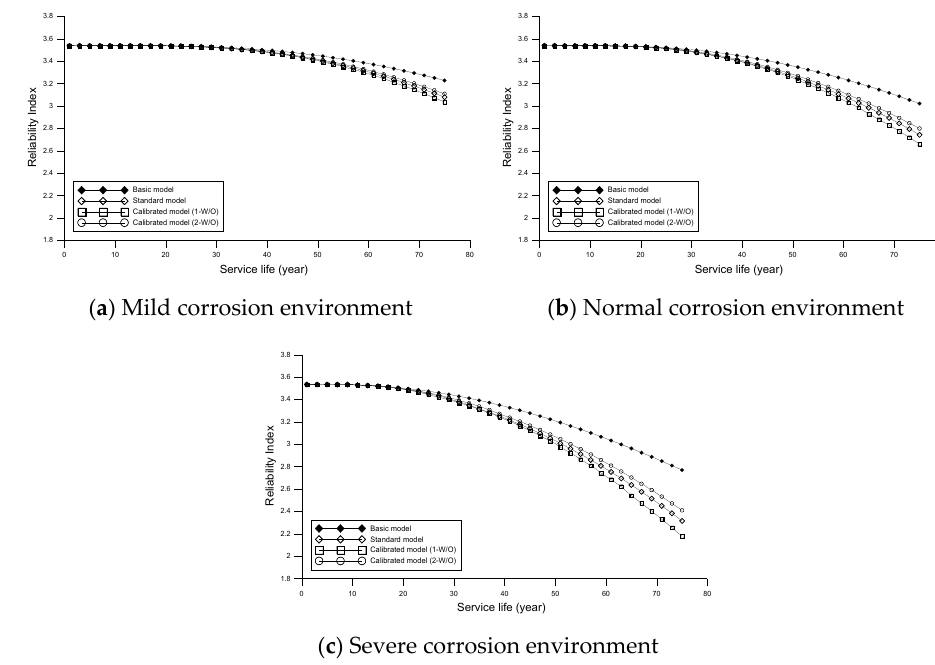
Figure 11. Reliability degradation under light traffic characteristics (without previous inspection).